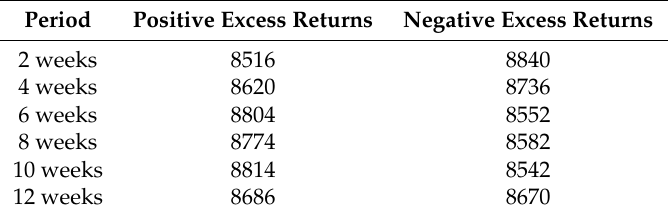
Table 1. Number of reports of positive or negative excess